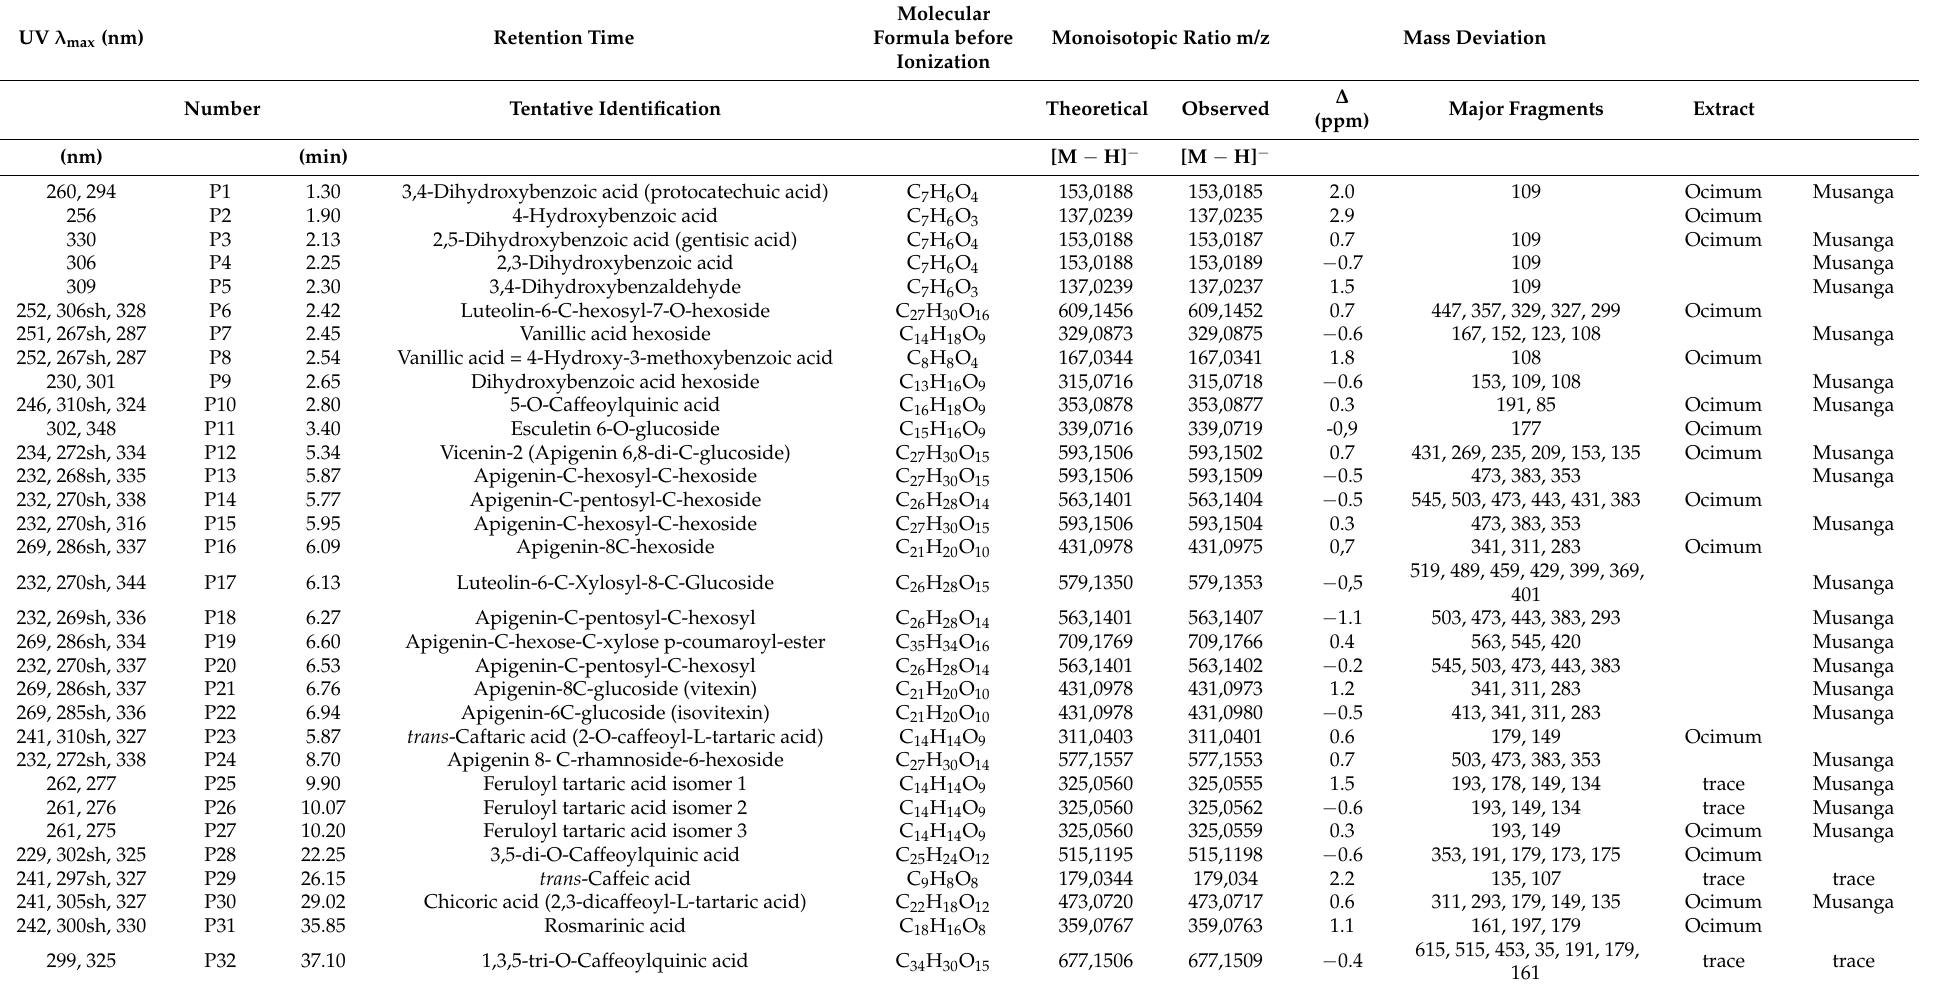
Table 1. Peaks are listed in the order of elution, with their names, molecular formula before ionization, retention times (RT), precursor ions, and fragmentation data of hydroxycin- namoylquinic acids. TR (min): retention time in minutes. Mol. form.: molecular formula. Theo. mass: theoretical monoisotopic mass of precursor ion [M − H] − . ∆ ppm: mass tolerance expressed in parts per